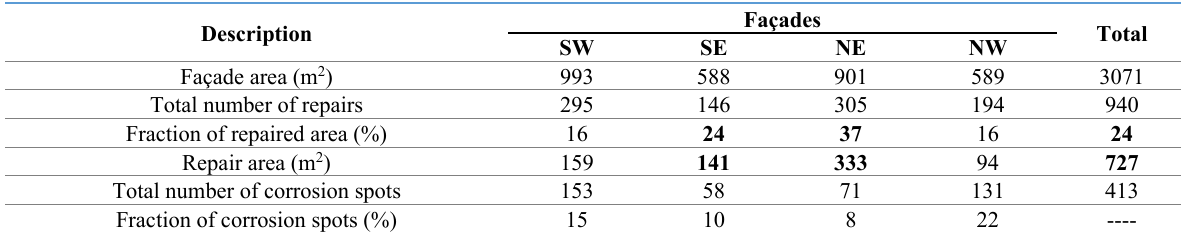
Table 1. Number and total area of patch repairs and respective fraction of area repaired in each façade; number of corrosion spots. Inspections made in 2016.